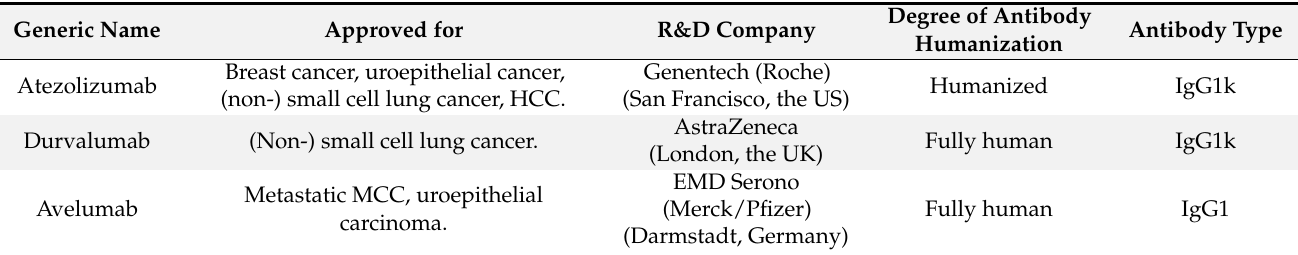
Table 3. PD-L1 inhibitors currently in use for clinical